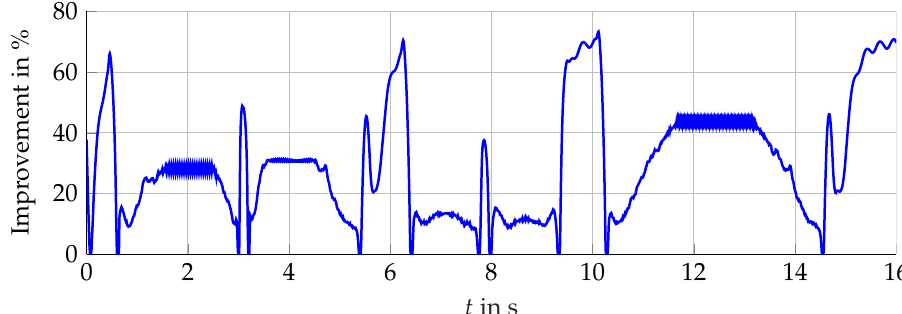
Figure 16. Relative interval width improvement in % with respect to ∑